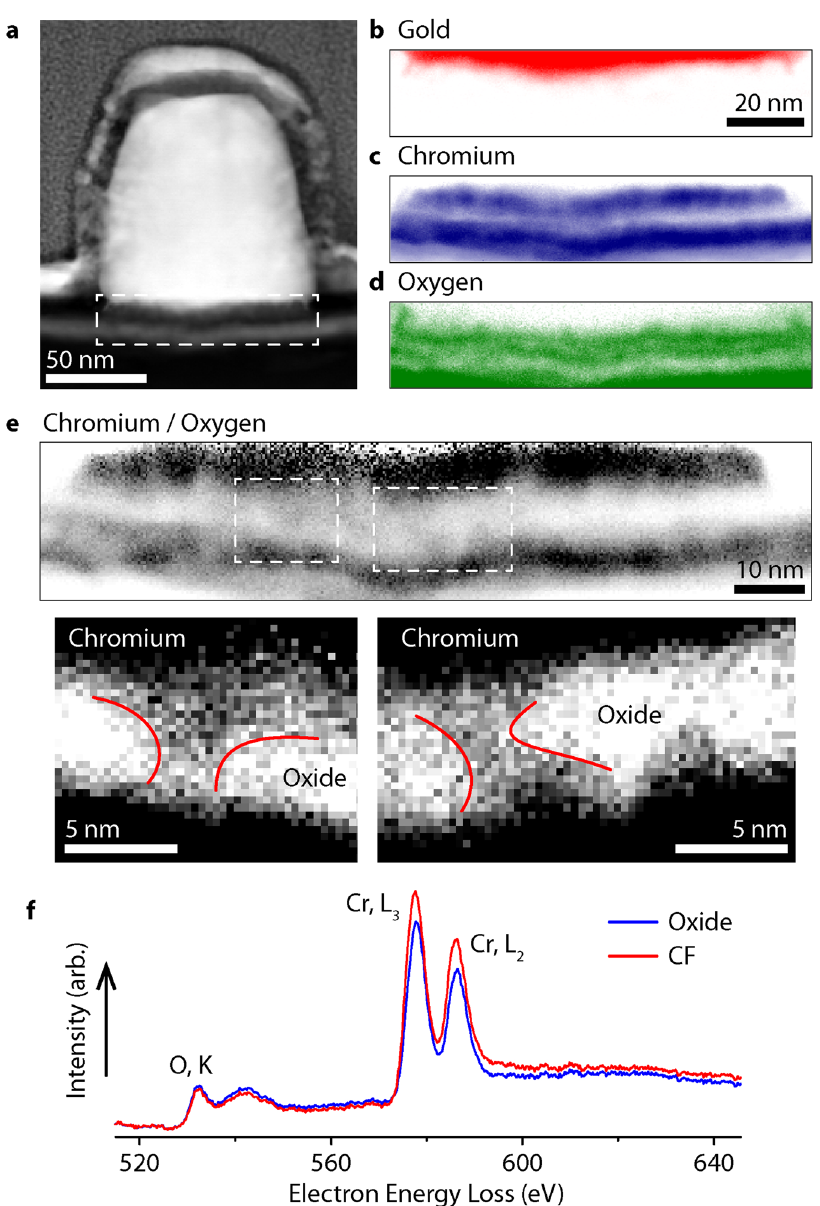
Figure 2. STEM measurement of plasmonically-formed conductive filaments in Cr oxide. ( a ) STEM HAADF image of a typical nanodot cross section. Note the sample was covered in protective layers during lamella fabrication (the visible interface is a result of a varying deposition method and rate). ( b – d ) Elemental distribution maps for Au (EDS, M edge), Cr (EELS, L edge) and O (EELS, K edge), within the highlighted region of ( a ). ( e ) Relative Cr/O ratio map (darker areas show higher relative Cr concentration). Expanded regions, with enhanced map contrast, reveal filaments of elevated Cr content spanning the oxide layer (lines added as an aid to the eye). ( f ) Typical EELs spectra from the oxide and CF